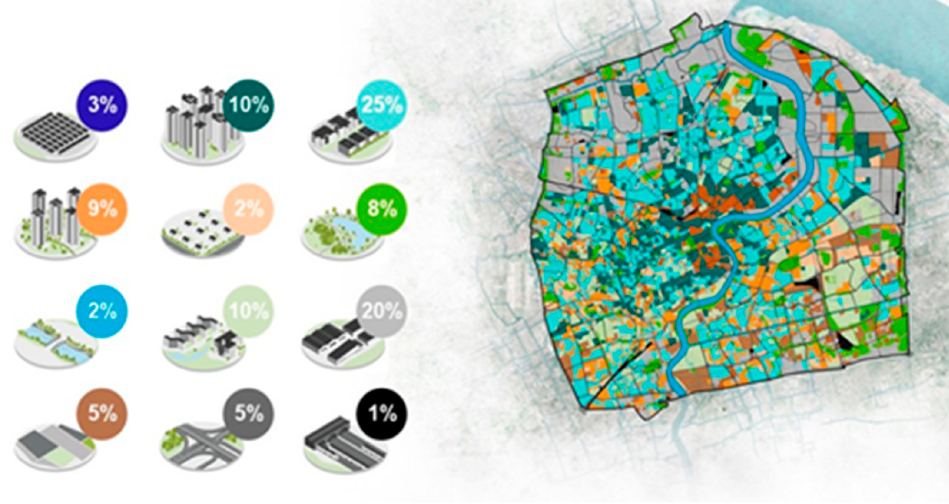
Figure 12. Machine Learning use the master planning area in different urban configurations.